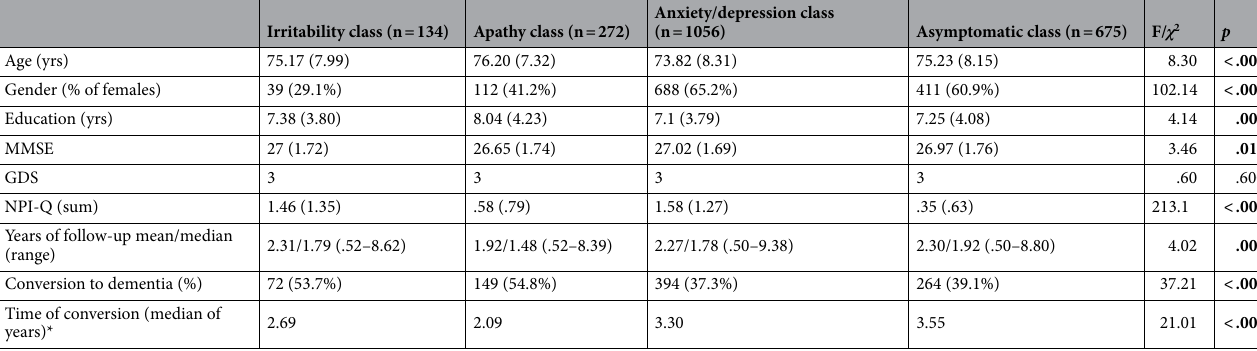
Table 3. Demographic characteristics of the study participants (n = 2137) stratified by the 4-class LCA model. Values represent mean (SD) or otherwise specified. MMSE mini-mental state examination, NPI-Q neuropsychiatric inventory questionnaire. *Kaplan Meier survival analysis.